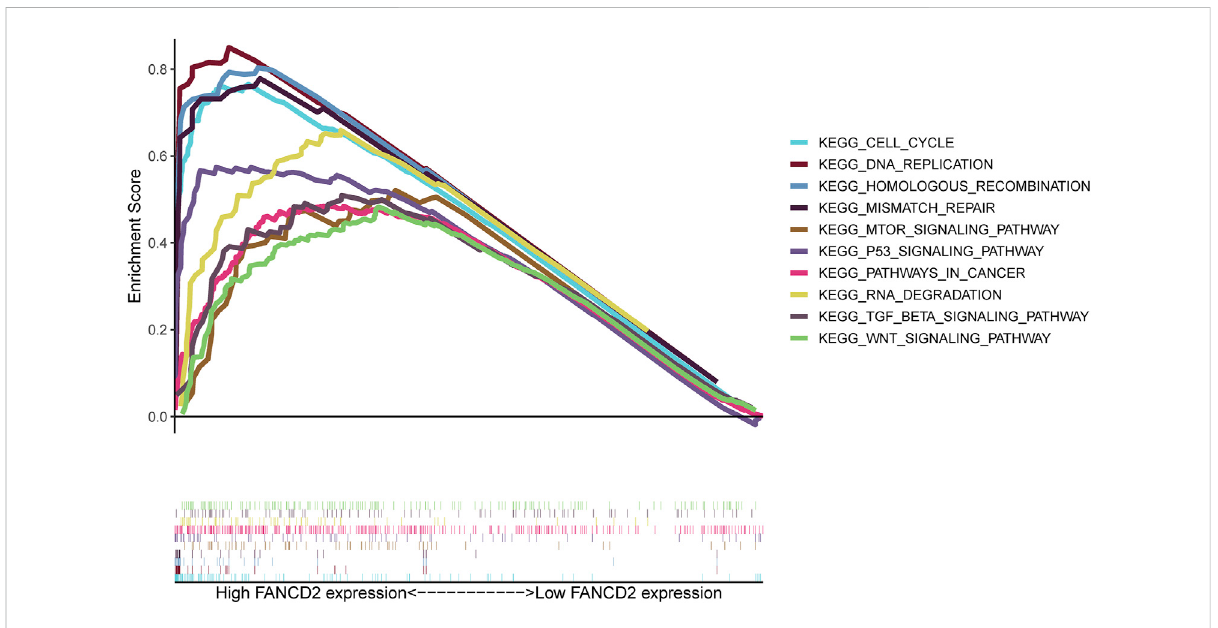
FIGURE 11 GSEA functional enrichment of FANCD2 in